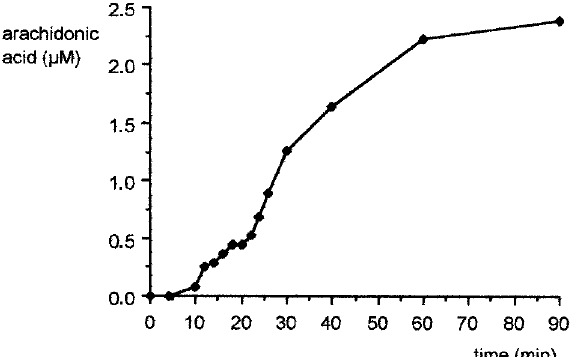
FIG. 1. Kinetics of the release of arachidonic acid by bovine platelets (8 ´ 10 8 cells/2ml) after stimulation with TPA (2 m M) in the presence of the dual cyclooxygenase–1/12-lipoxy- genase-inhibitor ETYA (10 m M), which inhibits the further metabolization of arachidonic acid to thromboxane B 2 and